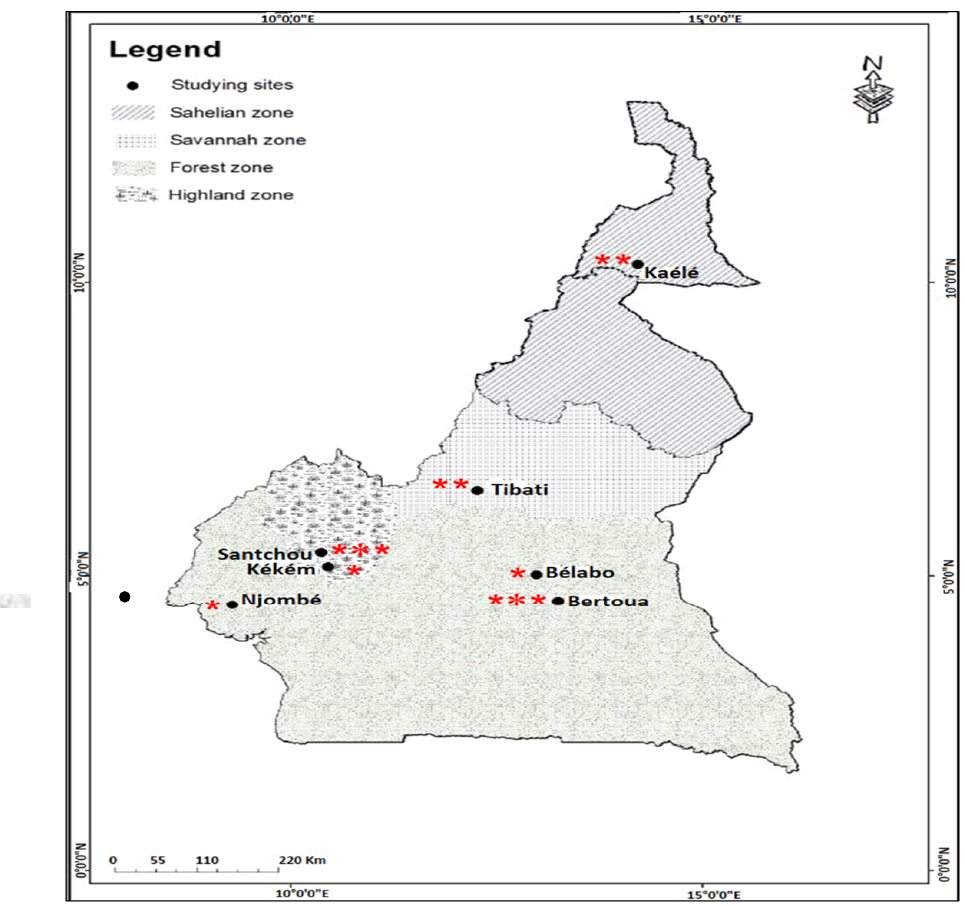
Figure 1. Map showing study sites with the number of collection periods (the number of red star * in site denote the number of collection time).